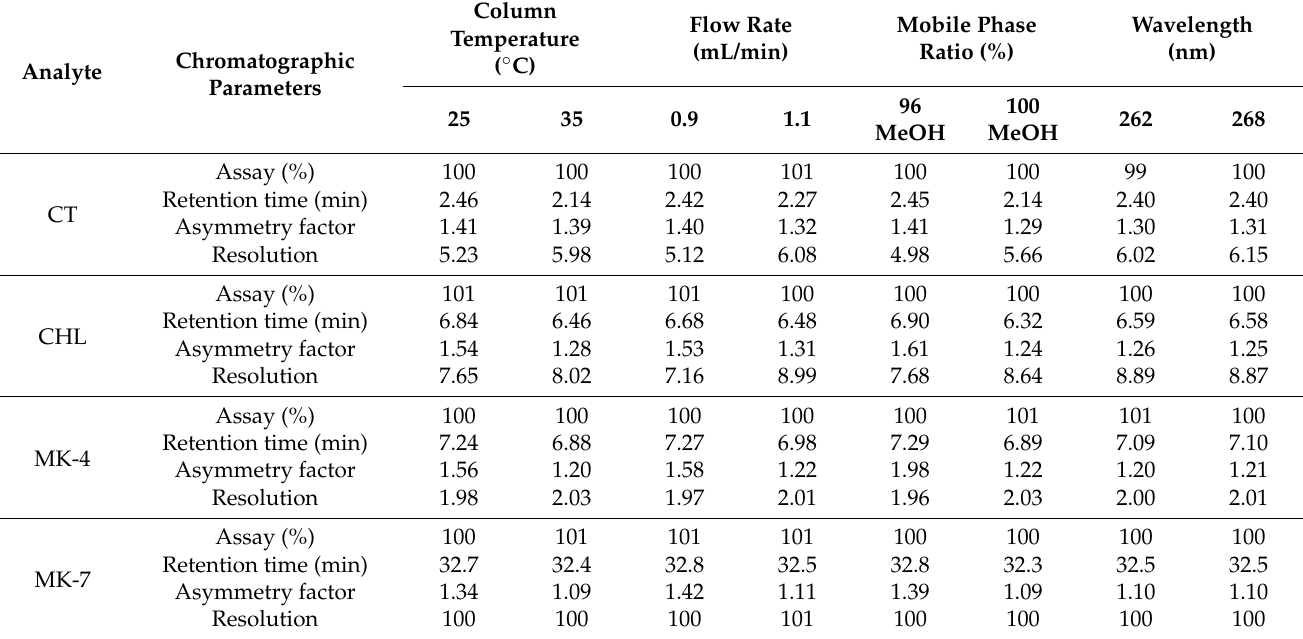
Table 7. Method robustness.